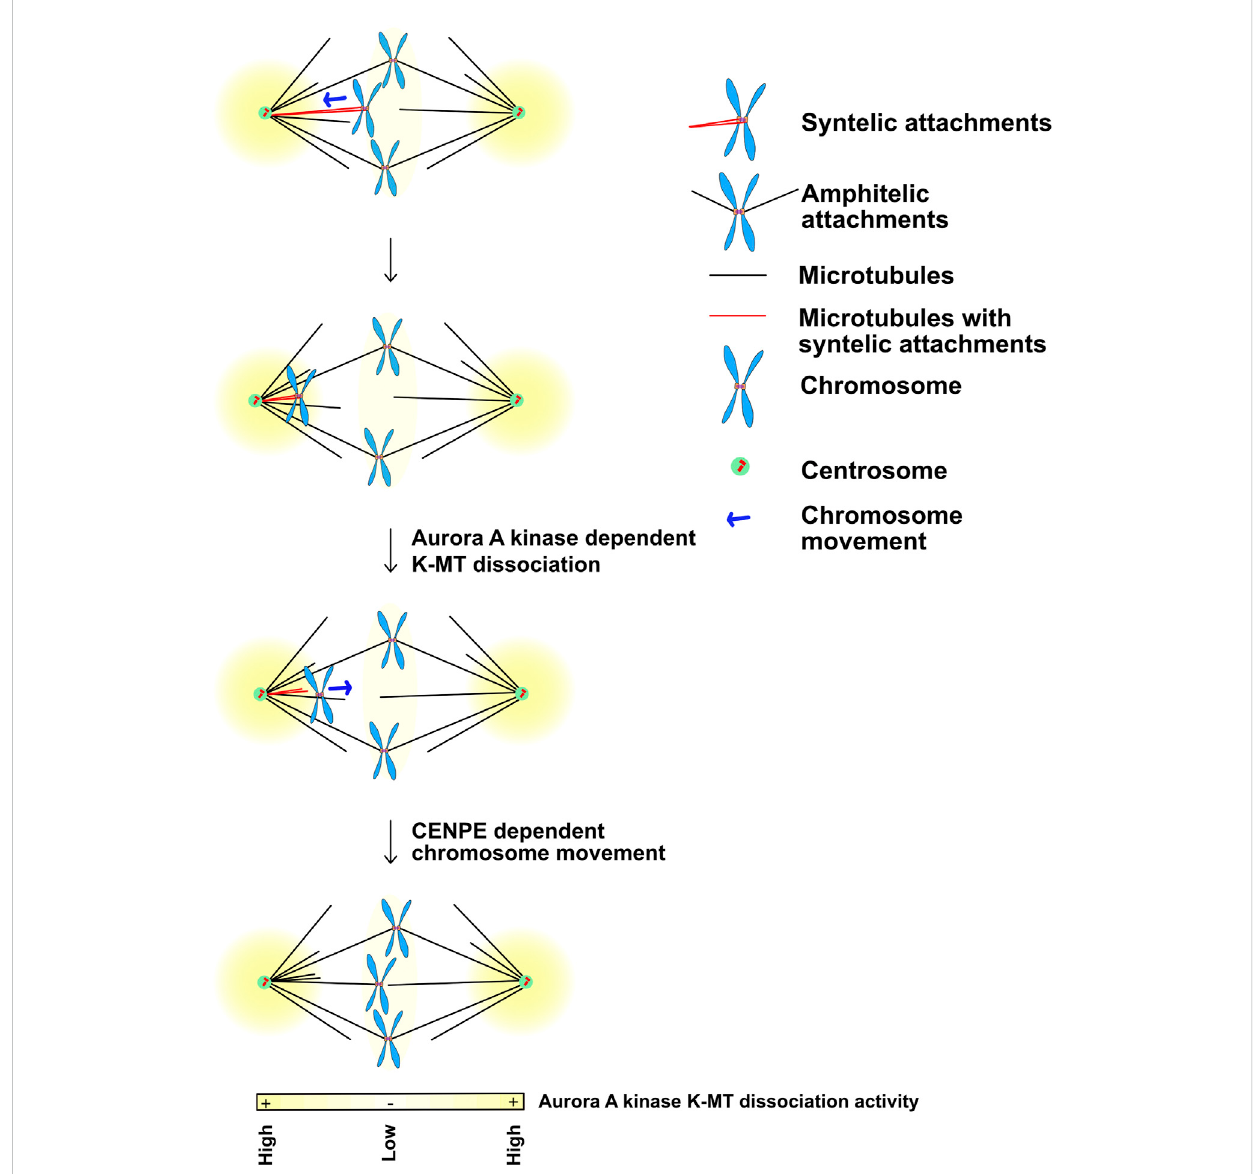
FIGURE 6 Movement of chromosomes into the Aurora A kinase activity gradients at poles may disassemble Ndc80 dependent kinetochore-microtubule interactions during prometaphase. Yellow: Aurora A kinase localizes and generates kinase activity gradients at the spindle poles. Kinetochores that acquire syntelic MT attachments (in red) are pulled towards the spindle pole while the majority of the chromosomes that obtain bipolar-amphitelic attachments align at the metaphase equatorial plate. High Aurora A kinase activity at the poles phosphorylates outer kinetochore KMN substrates including Ndc80, which allows them to release bound microtubules. It is likely that the chromosomes with lost kinetochore-microtubule interactions translocate back towards the equatorial plate by the plus-end directed kinesin CENP-E until they reach a lower Aurora A activity region that would allow Ndc80 to bind microtubules again. Figure representation: Spindle poles, green circle; Centrioles, red cylinders; Chromosome arms, blue; Kinetochores, orange rectangles; Microtubules, black lines; Syntelic attachments, sister kinetochores attached to microtubules from one pole, red microtubules; Amphitelic attachments, sister kinetochore attached to microtubules from opposite poles; Chromosome movement, blue arrow; Yellow heat map represents Aurora A kinase activity gradient. Abbreviation: K-MT, Kinetochore-Microtubules; MT,